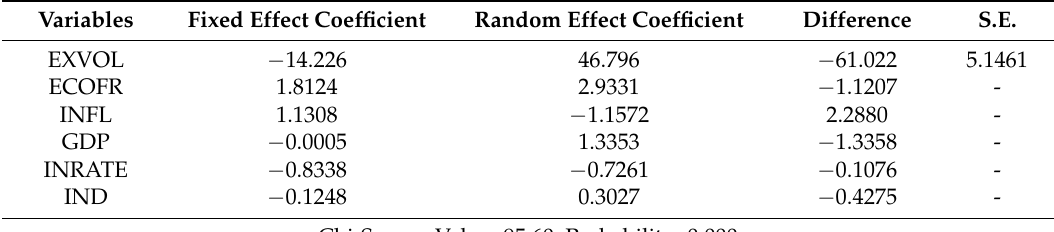
Table A8. Hausman Test: International Trade and Exchange Rate Volatility (TGARCH).